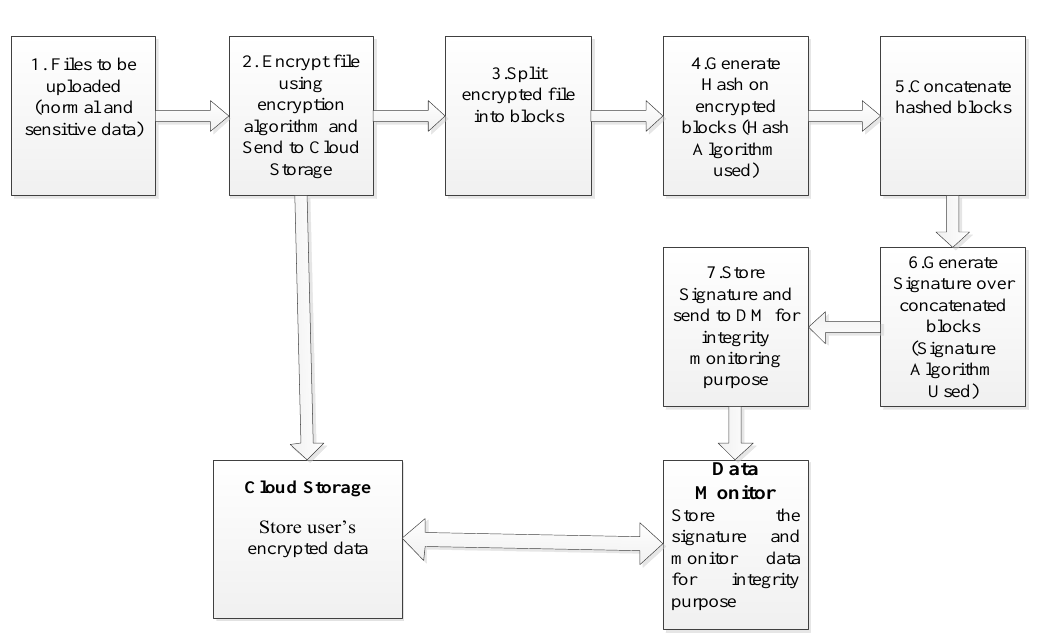
Figure 2. The working of